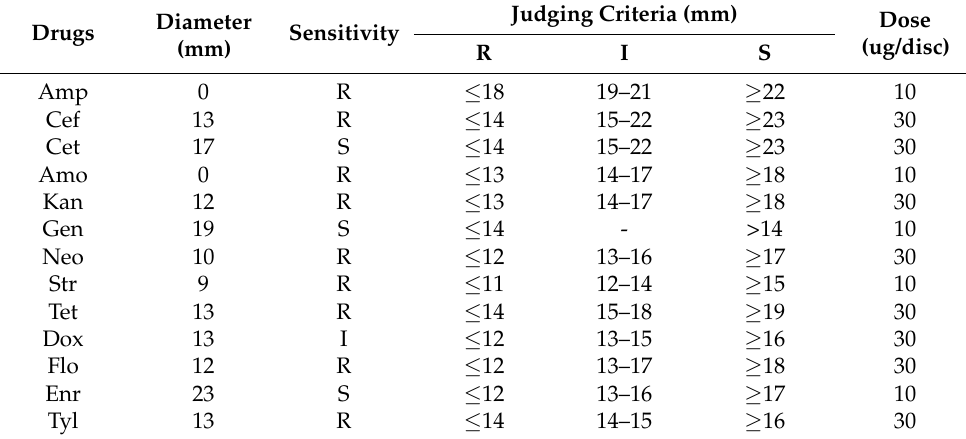
Table 2. Results of the drug susceptibility